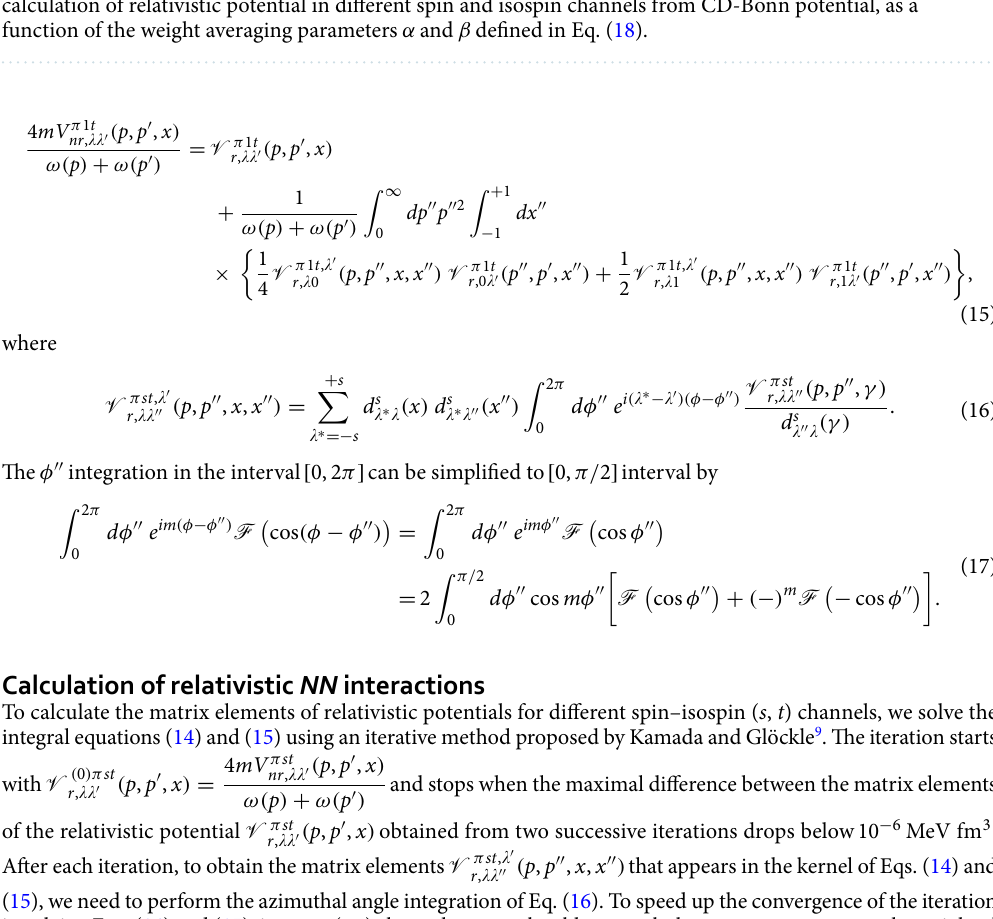
Table 1. The number of iterations N iter to reach convergence in the solution of Eqs. (14) and (15) for the calculation of relativistic potential in different spin and isospin channels from CD-Bonn potential, as a function of the weight averaging parameters α and β defined in Eq. (18).